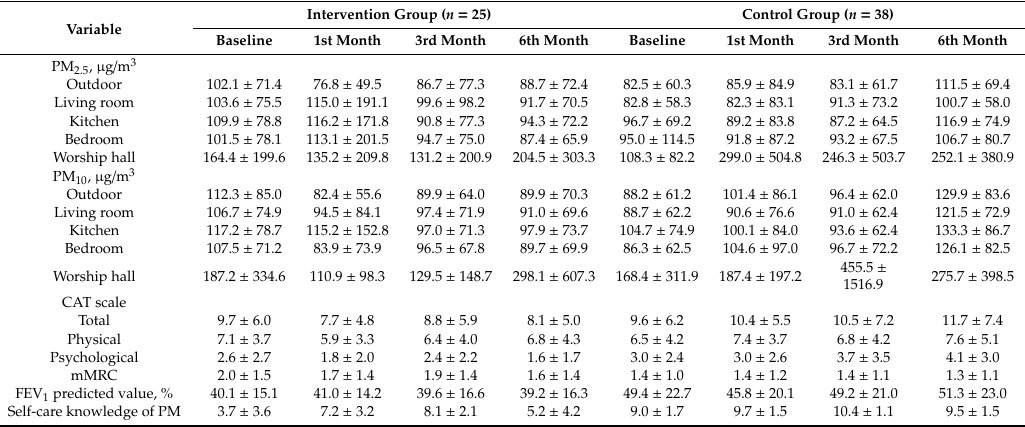
Table 2. Descriptive statistics of dependent variable in each study group across the measurements ( n = 63).